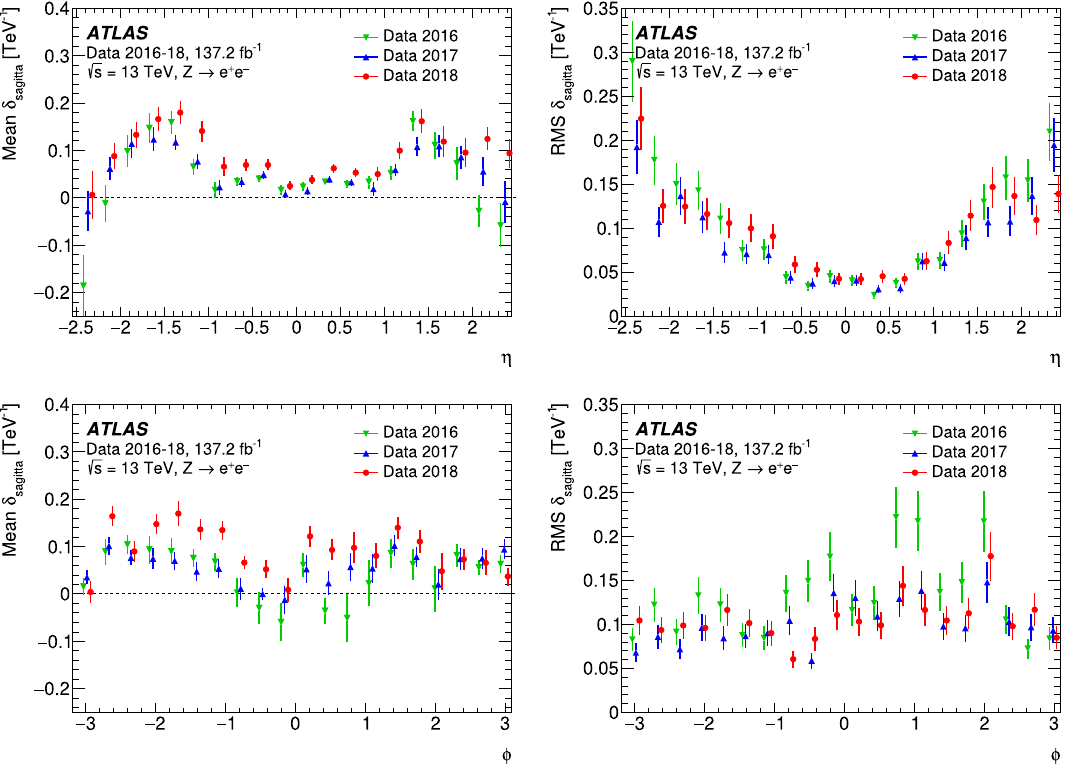
Fig. 21 Sagitta biases versus η (top) and φ (bottom) for the E / p method. The average (left) and the RMS (right) of the sagitta bias is shown. The markers of the data points of the different years are slightly shifted in η and φ for better visibility. The error bars represent the statistical